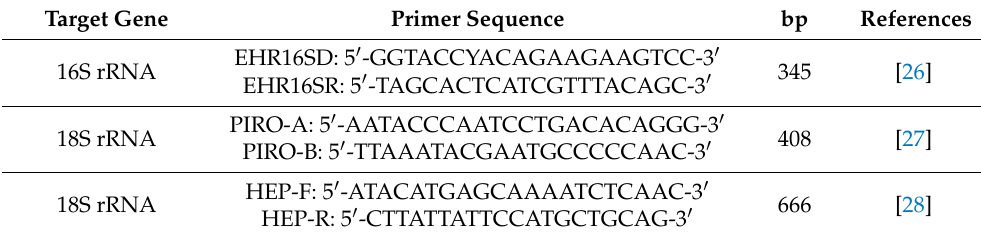
Table 1. Primer sequences used for the detection of tick-borne agents. Target Gene Primer Sequence